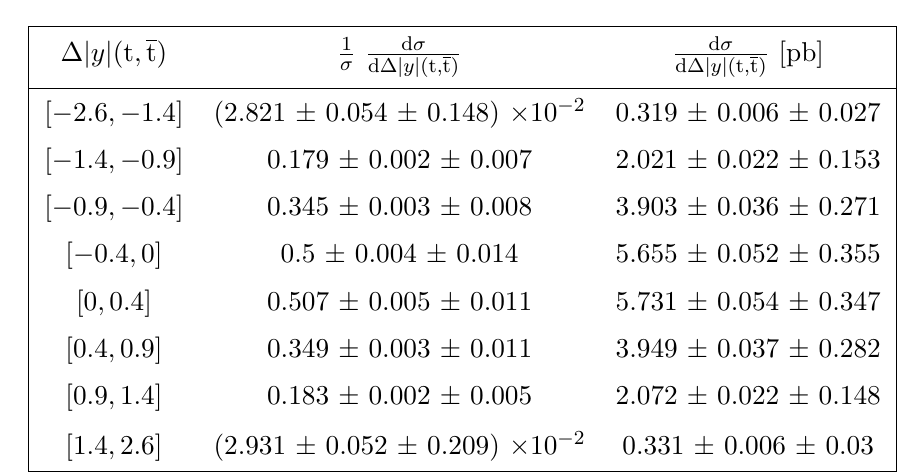
Table 27 . The measured di(cid:11)erential cross section and bin boundaries for each bin of the normalized and absolute measurements of the tt di(cid:11)erential cross section at particle level in the (cid:12)ducial phase space as a function of (cid:1) j y j (t ; t) are tabulated.